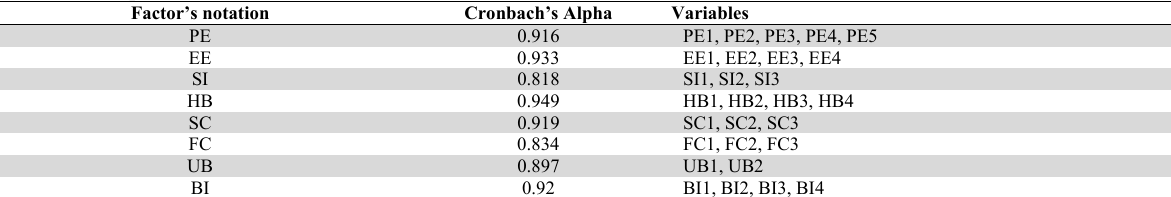
Cronbach's Alpha test